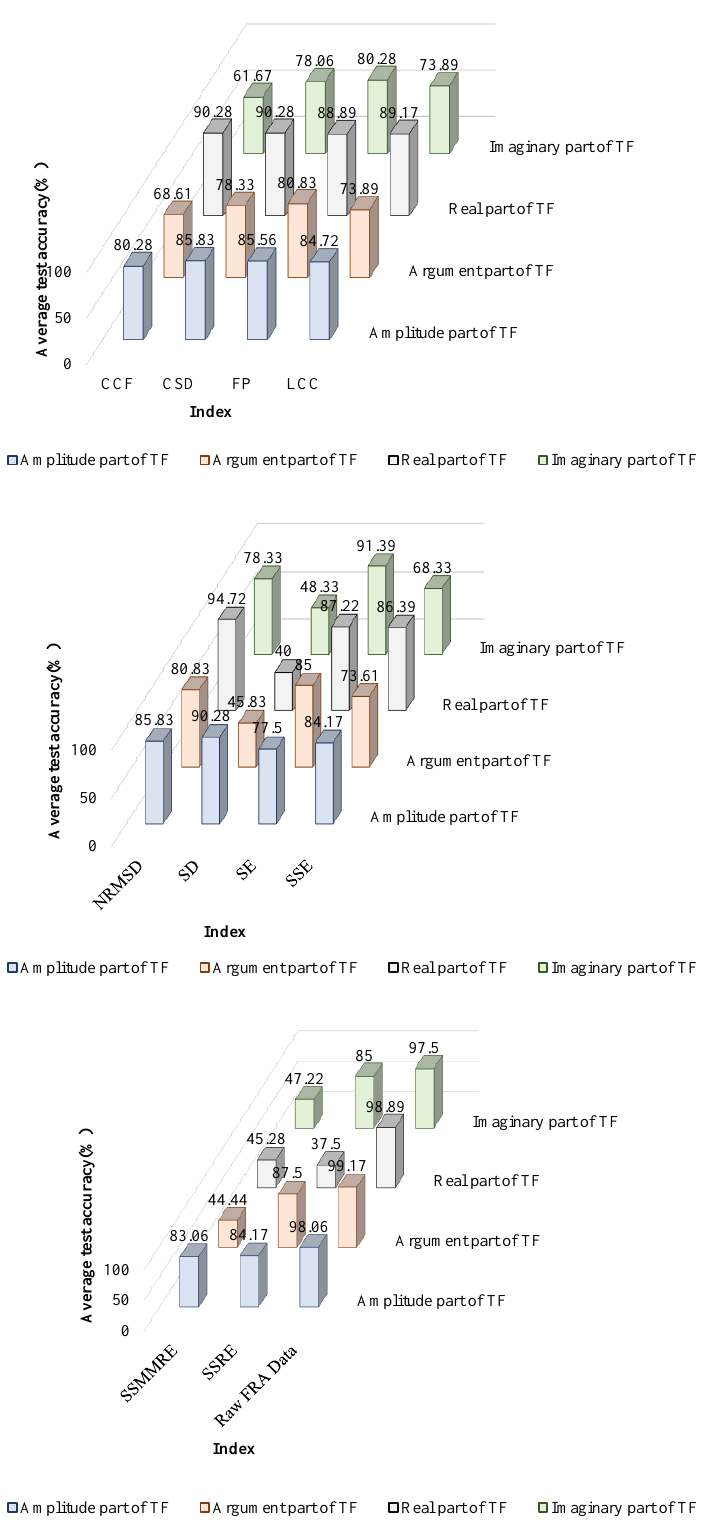
Figure 7. Evaluating the performance of the MLP model in determining the DSV fault location using direct data of FRA and the extracted features by statistical indices.